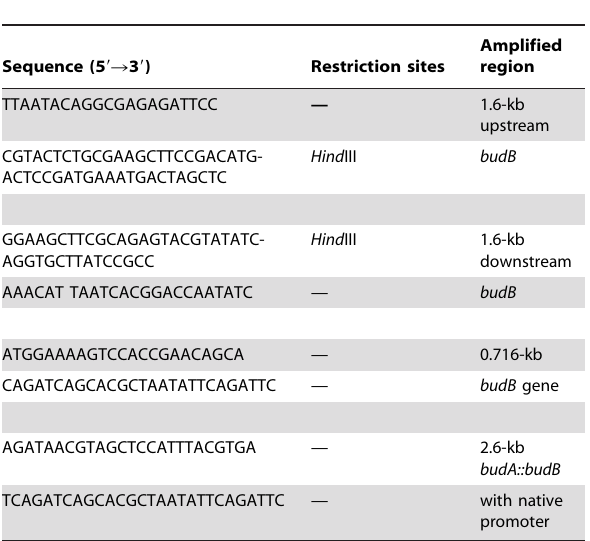
Table 3. Oligonucleotides used in this study for cloning and